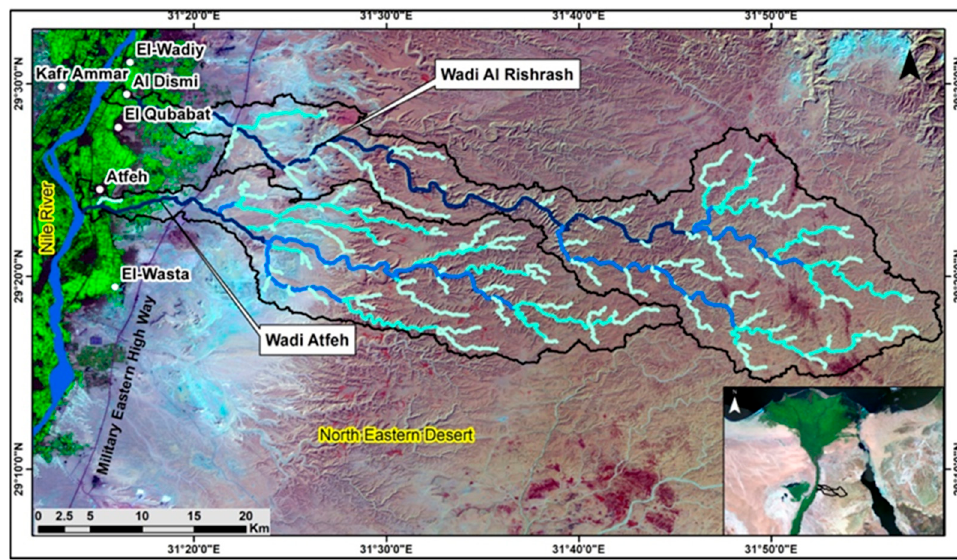
Figure 1. Location map of the study area, showing the location of the Wadi Al Rishrash and Wadi Atfeh catchments and their major stream networks superimposed on a Landsat 8 false color composite image.